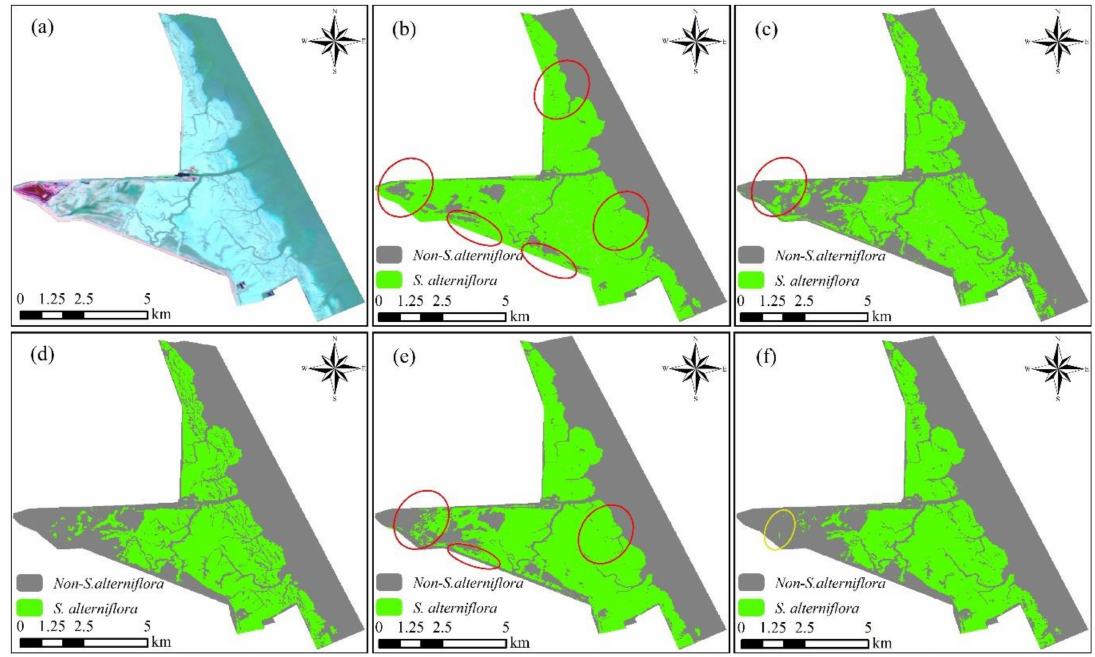
Figure 5. Classification maps of S. alterniflora using the EOCC and SVM algorithms in the best SSA and the second PB-NDVI-TSA for the DMNNR. ( a ) RGB composite (R: NDVI _May, G: NDVI _November, B: NDVI _December) of NDVI images in the DMNNR. ( b , c ) Classification maps of S. alterniflora